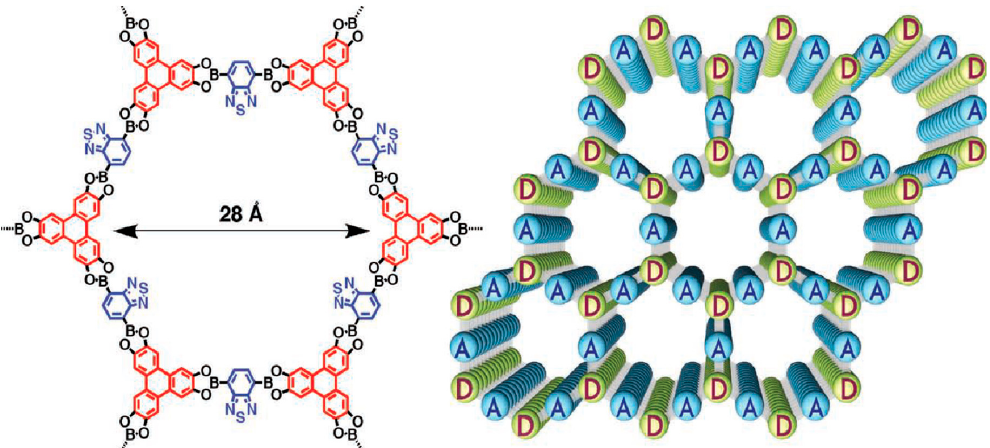
Figure 11. Schematic representation of 2D D-A COF with self-sorted and periodic electron donor-acceptor ordering and bicontinuous conducting channels ( right : structure of one hexagon; left : a 3 × 3 grid). Reproduced with permission from [190].